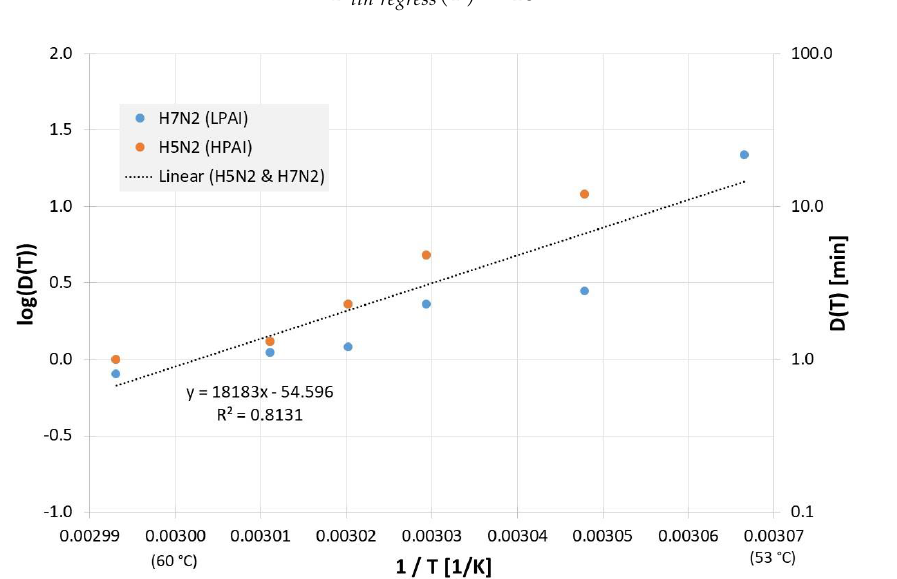
Figure 2. Correlation between 1/T and log(D(T)) for all published influenza virus thermal inactivation data in PBS along with the linear regression curve and for better understanding, D(T) is also given on the right Y-axis in a logarithmic scale. (LPAI: low pathogenic avian influenza, HPAI: high pathogenic avian influenza).